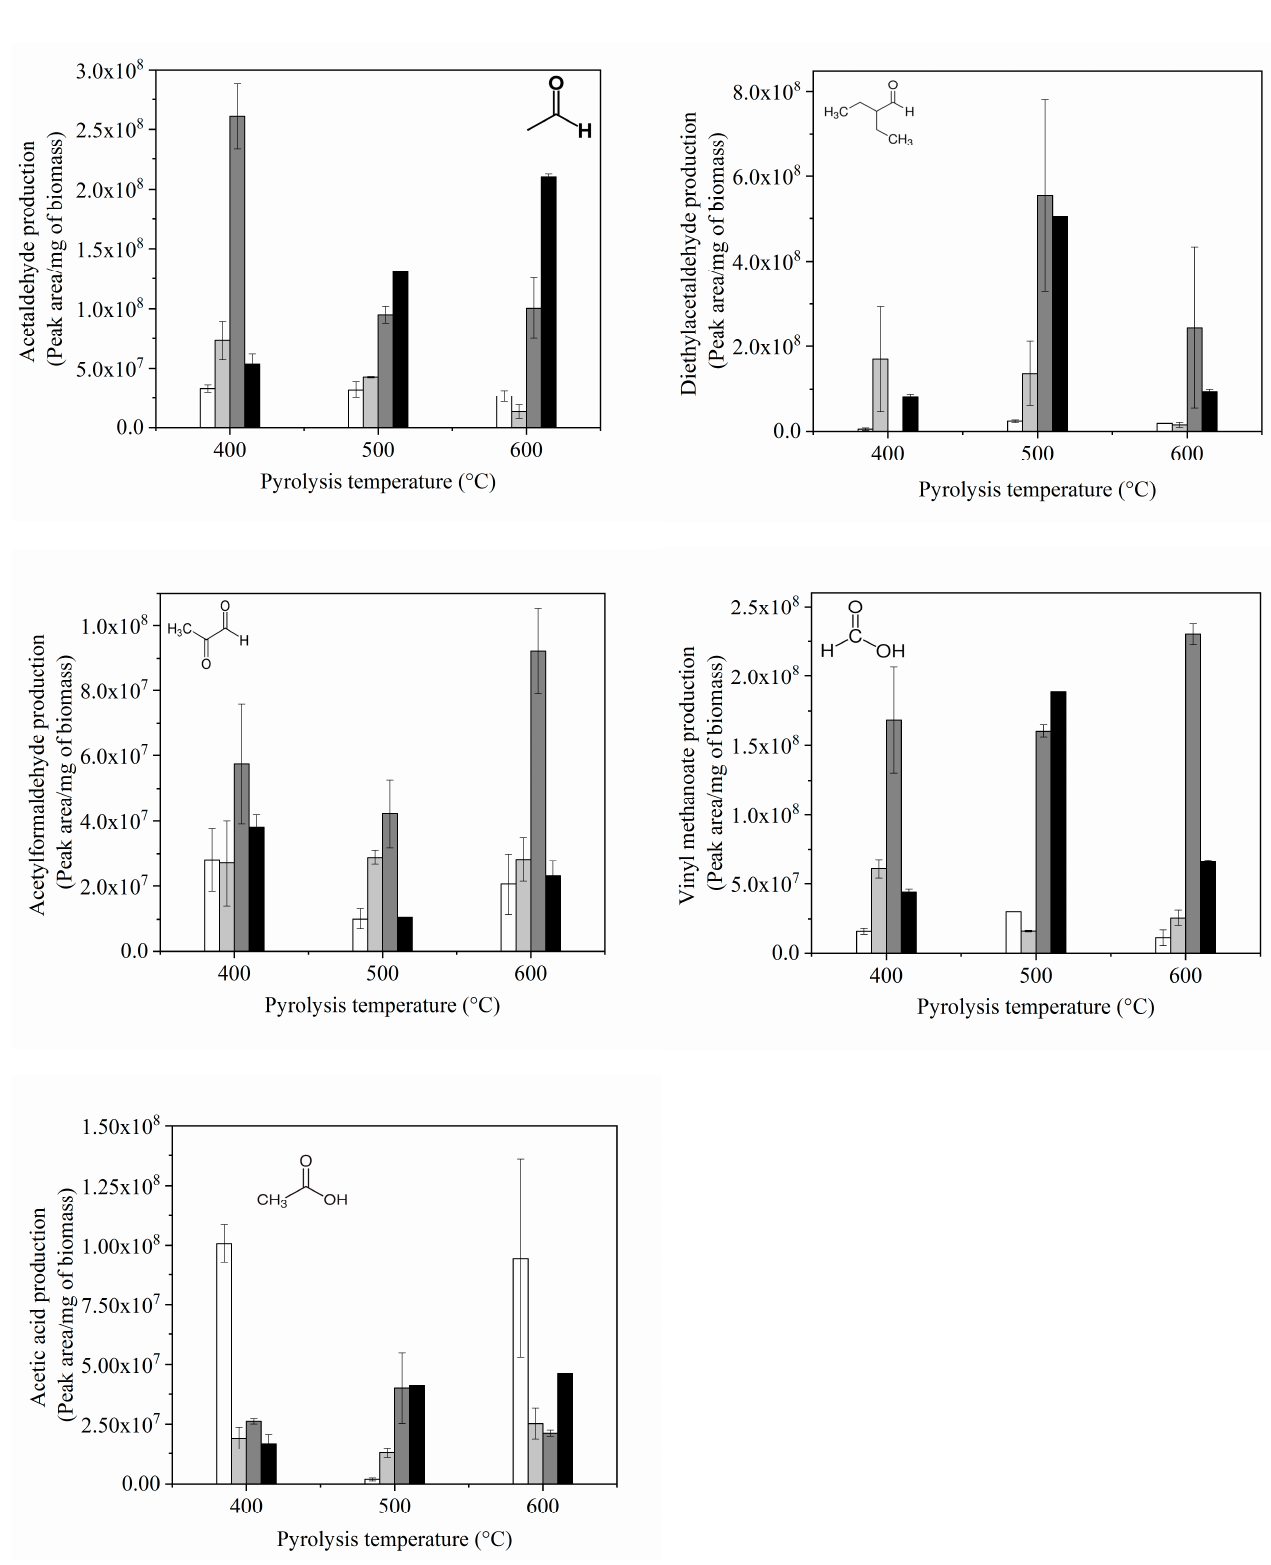
Figure 10. Formed oxygenated pyrolytic compounds (<5 Carbons) from coffee husks as a function of pyrolysis temperature and pretreatment acid type. Symbols: (cid:3) Untreated biomass; (cid:4) biomass pretreated with acetic acid; (cid:4) biomass pretreated with HNO 3 (0.1%)/H 2 SO 4 (0.1%); (cid:4) biomass pretreated with H 2 SO 4